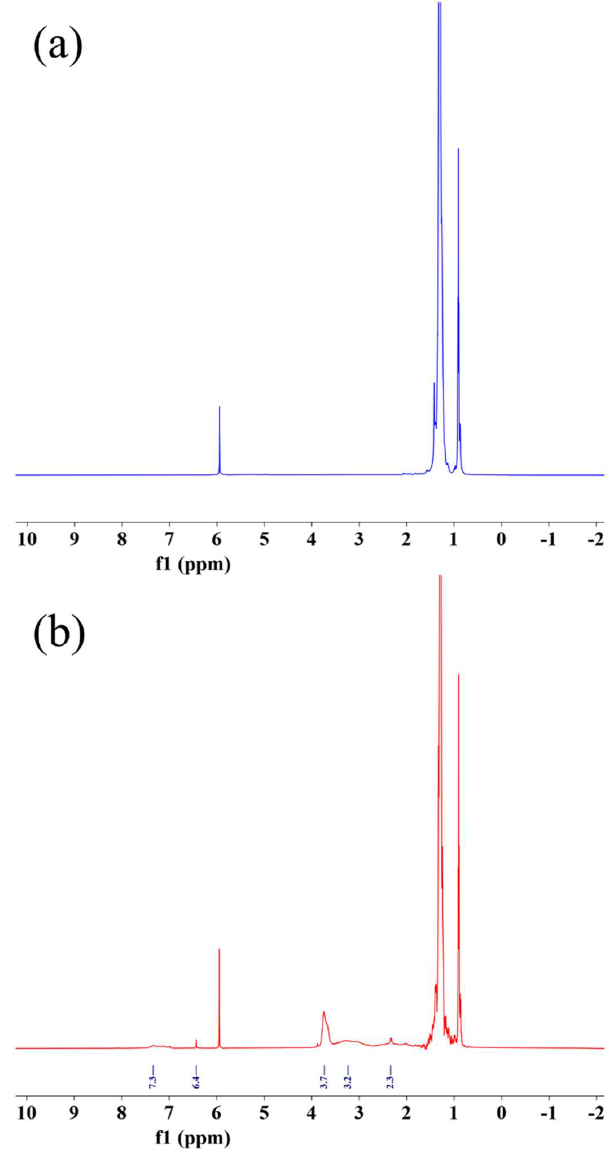
Figure 3. 1 H NMR spectra of PEW sample ( a ) and PEW- g -MAH-MMA sample ( b ).